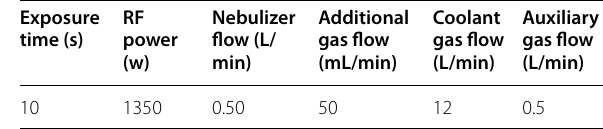
Table 1 Instrumental parameters of ICP-OES for Si